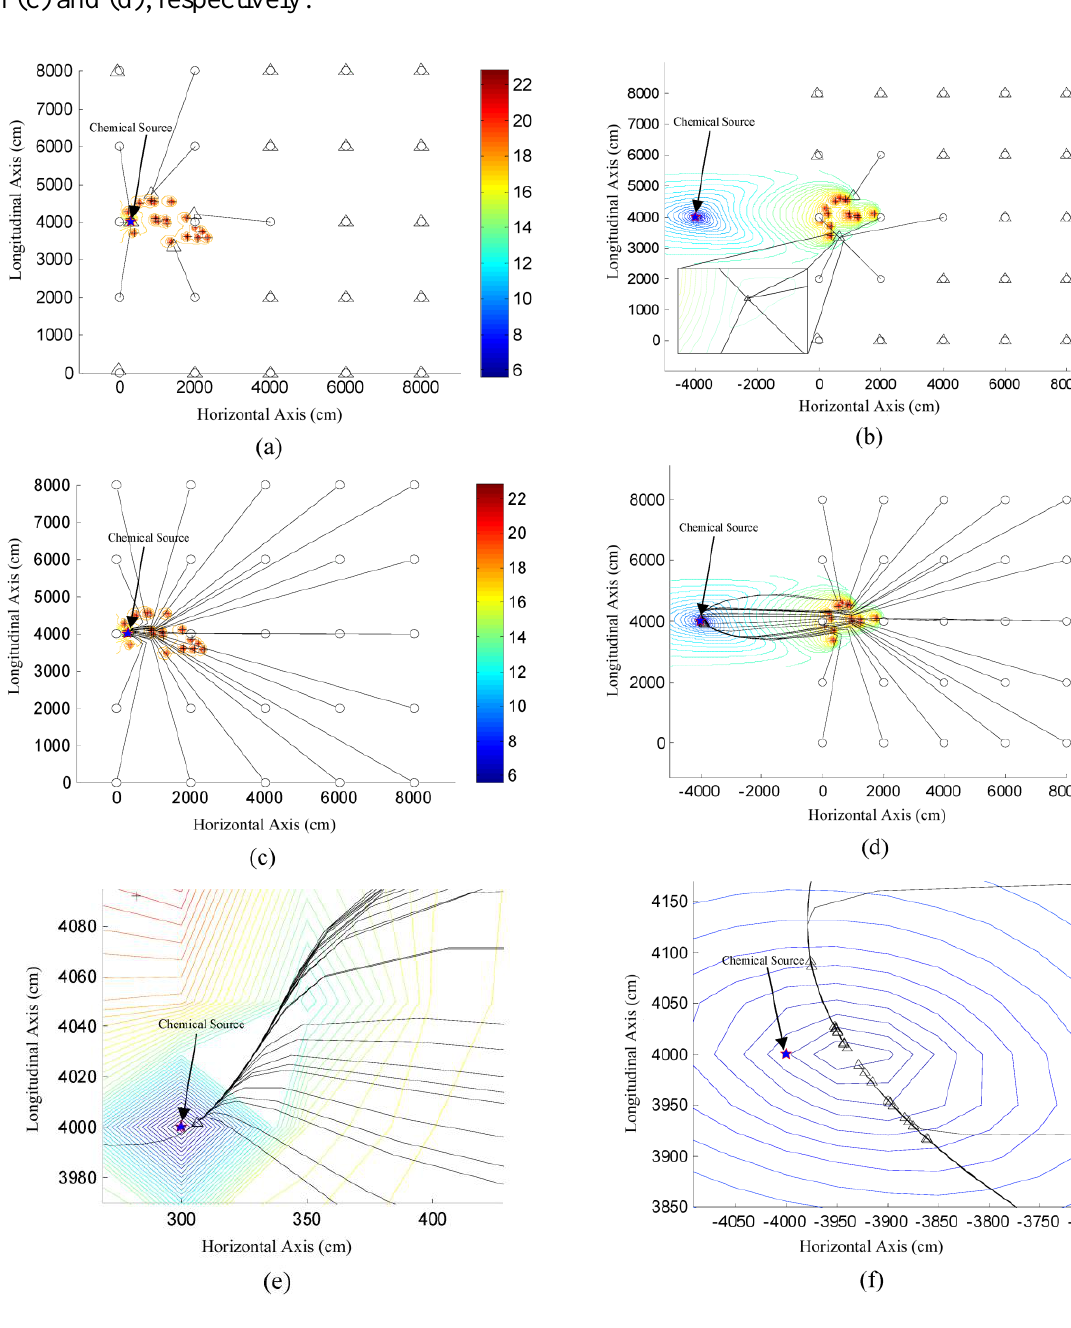
Figure 8. The influence of initial point on the localization performance of TRR and DLSE. The initial points, sensor nodes and the final global estimates are denoted as circles, crosses and triangles, respectively. The source is located at (300,4000) cm in (a) and (c), while it is located at (−4000,4000) cm in (b) and (d). ( a ) and ( b ) show the localization results of TRR, while ( c ) and ( d ) illustrate the variation of global estimates in the process of performing DLSE. ( e ) and ( f ) are the magnified versions of a small rectangular area around the source in (c) and (d),